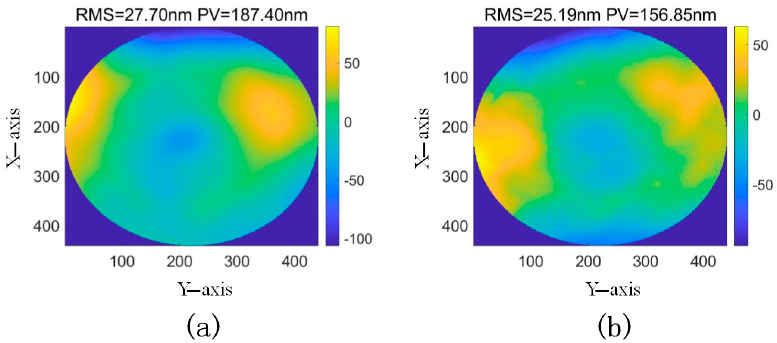
Figure A1. Experimental setup for measuring the distance 𝑑 (cid:3043) .